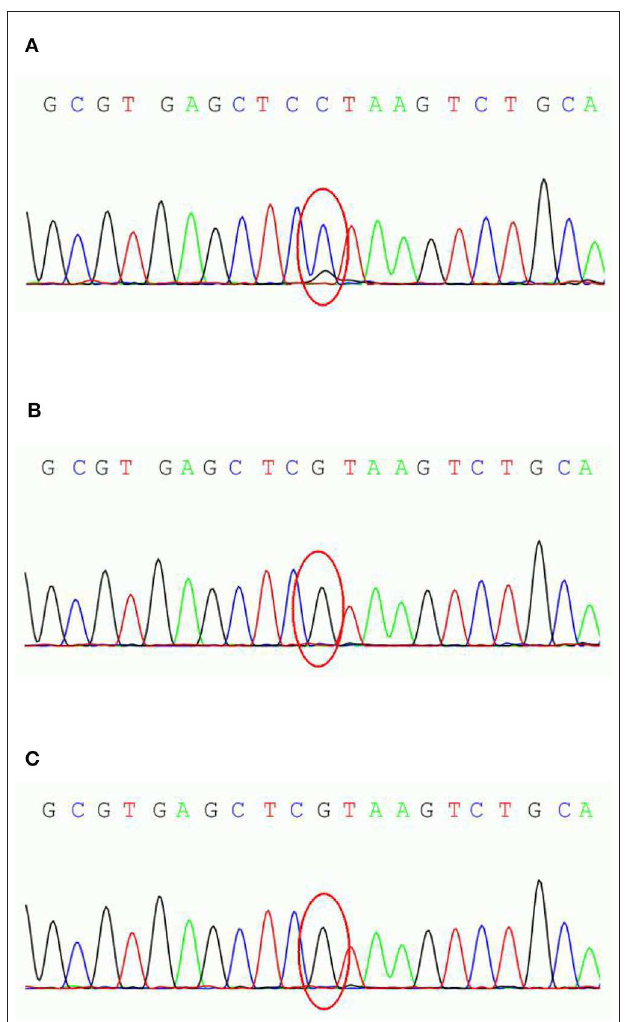
FIGURE 1 | PCDH19 sequencing results of the parent-proband trio. (A) the male patient; (B) patient’s father; (C) patient’s mother.